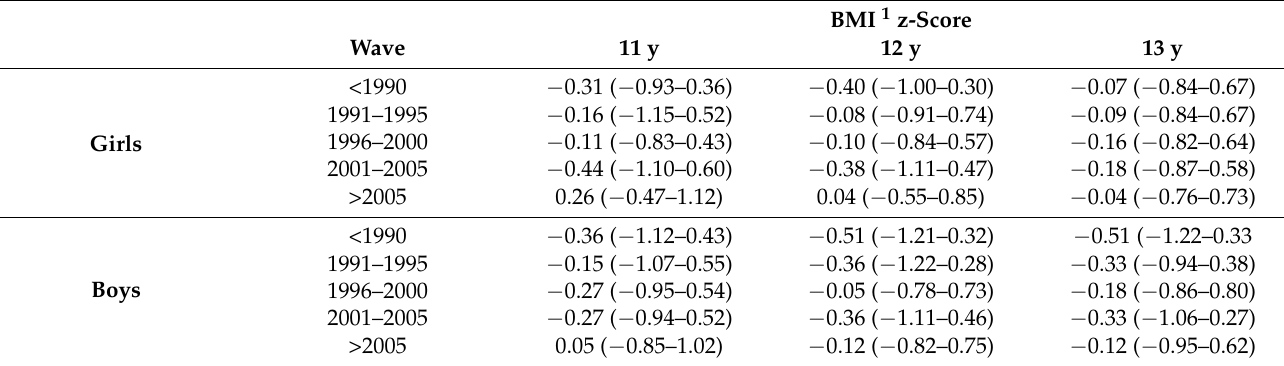
Table 2. Descriptive characteristics of boys and girls.